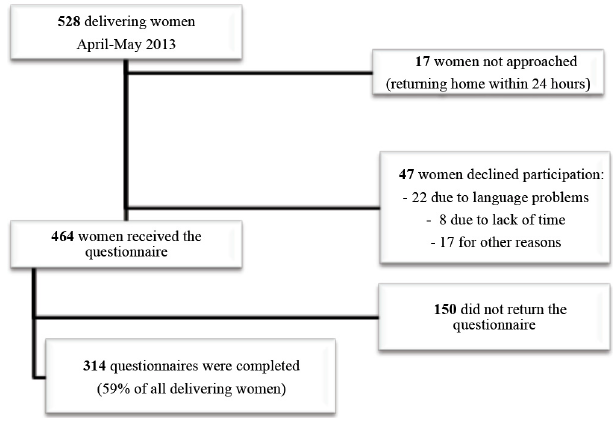
Figure 1. Flowchart of participants’ enrollment.